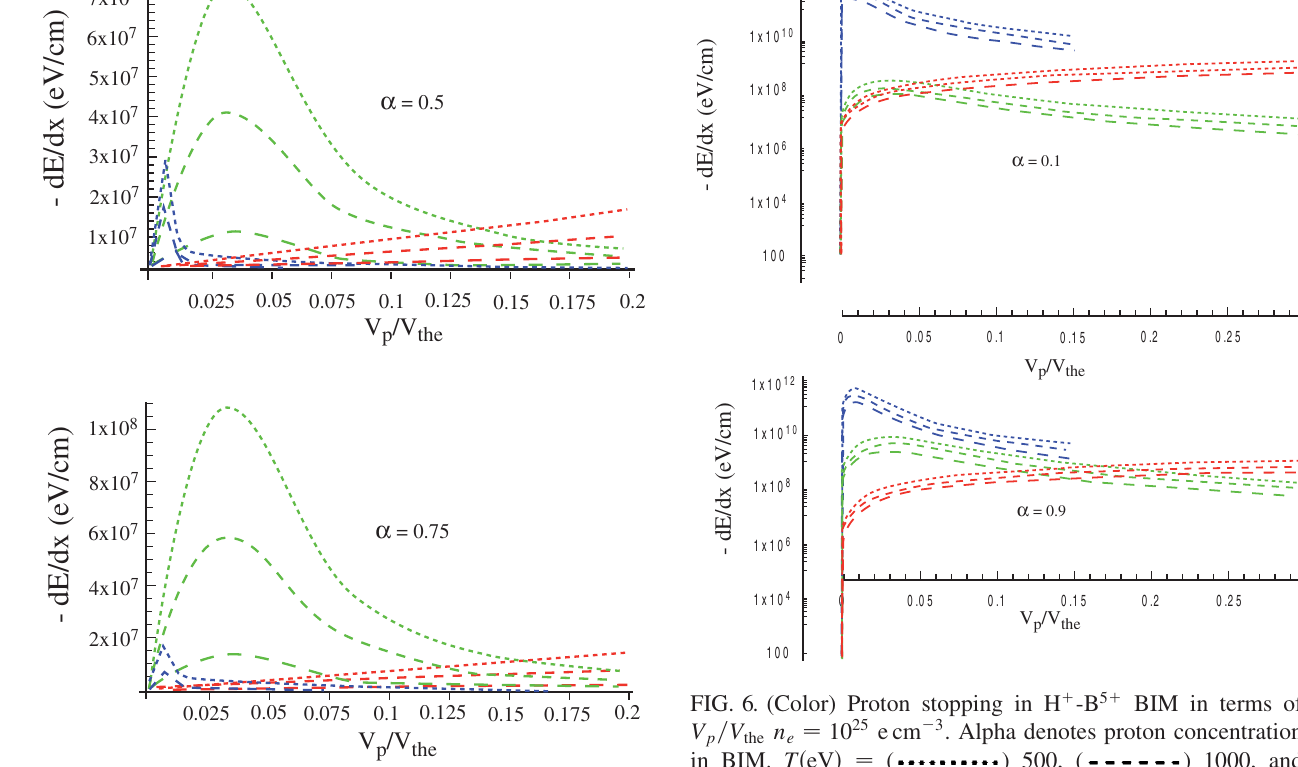
FIG. 6. (Color) Proton stopping in H þ - B 5 þ BIM in terms of =V n ¼ 10 25 e cm (cid:1) 3 . Alpha denotes proton concentration V p the e in BIM. T ð eV Þ ¼ ( ) 500, ( ) 1000, and ( ) 2000. Dark gray (red) pertains to e stopping, light gray (green) to H þ stopping, and black (blue) to B 5 þ stopping.